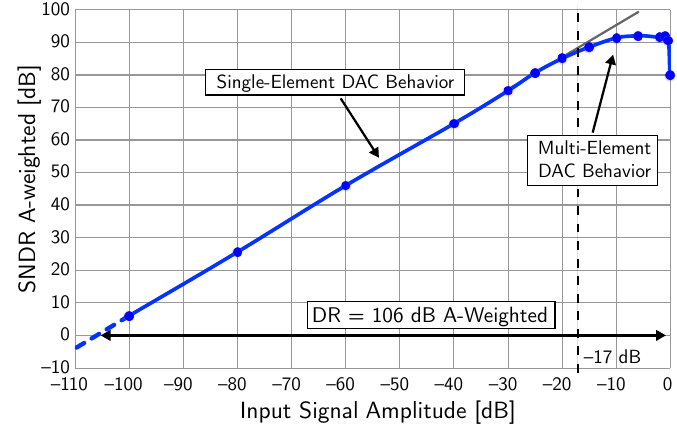
Figure 20. Measured SNDR as a function of the input signal amplitude (example 4).